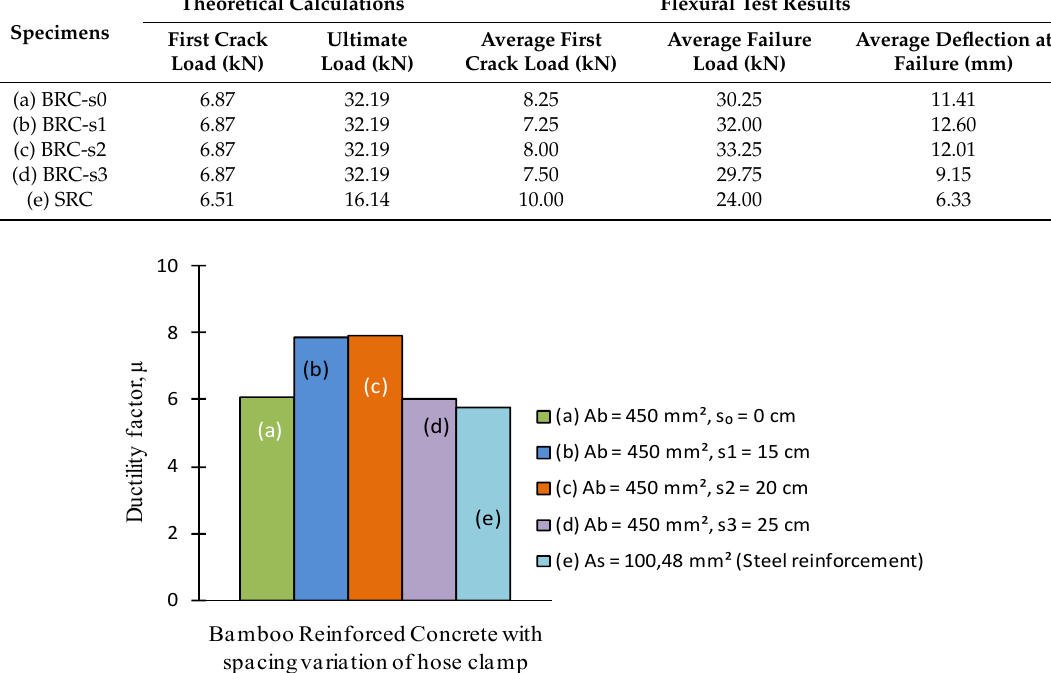
Figure 17. The e ff ect of hose-clamp distance on the ductility Figure 17. The effect of hose-clamp distance on the ductility value.